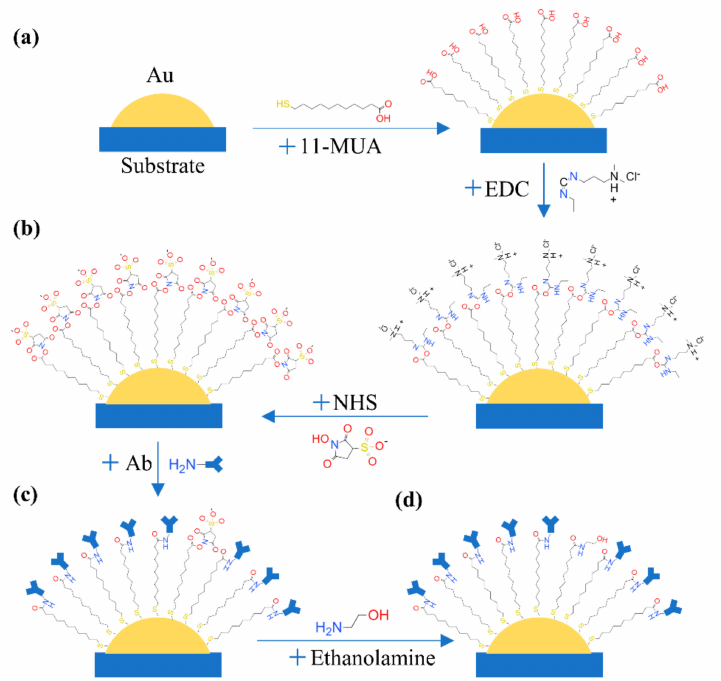
Figure 5. Functionalization of AuNPs. ( a ) The reaction between AuNPs and 11-MUA; ( b ) Active carboxyl via EDC and NHS; ( c ) Bonding antibody; ( d ) Quench amine reaction by